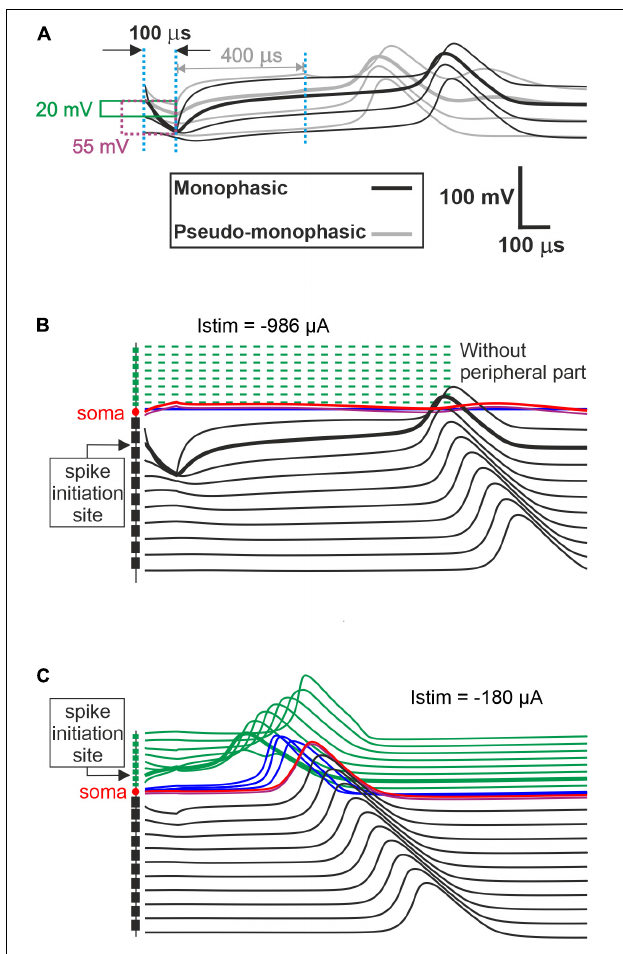
FIGURE 5 | Comparison of the transmembrane voltage just above the threshold. (A) Comparison between excitation of the initiation sites for both pulse shapes. During the first cathodic phase, the strongest deviations from the resting voltage appear in a central process region close to the soma. Hyperpolarization of the monophasic pulse (55 mV) is almost three times larger than for the pseudomonophasic pulse (20 mV). In monophasic stimulation, the central process compartment with the strongest hyperpolarization elicits the spike by break excitation (thick black line), and this spike is conducted in both directions (thin black lines). Break excitation is an overshoot of membrane voltage in the direction of the resting potential after a strong hyperpolarization. This overshooting trend is strongly supported by the weak second phase of the pseudomonophasic pulse (gray lines). Consequently, the pseudomonophasic stimulation needs less hyperpolarization during the first phase. (B) Degeneration status AS6, without peripheral process, when monophasic pulse is applied. (C) Excitation of fiber with healthy status for monophasic